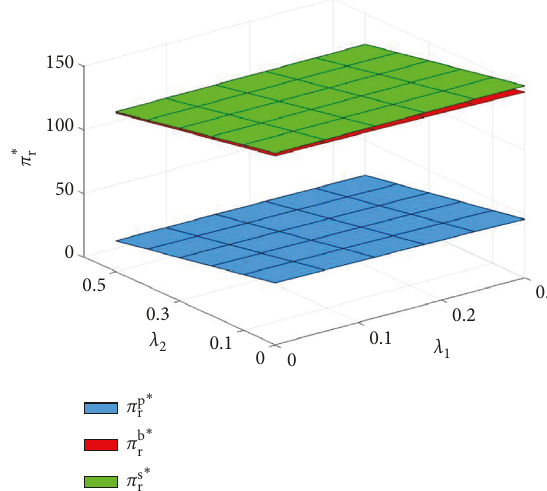
Figure 6: Impact of change in λ profit.